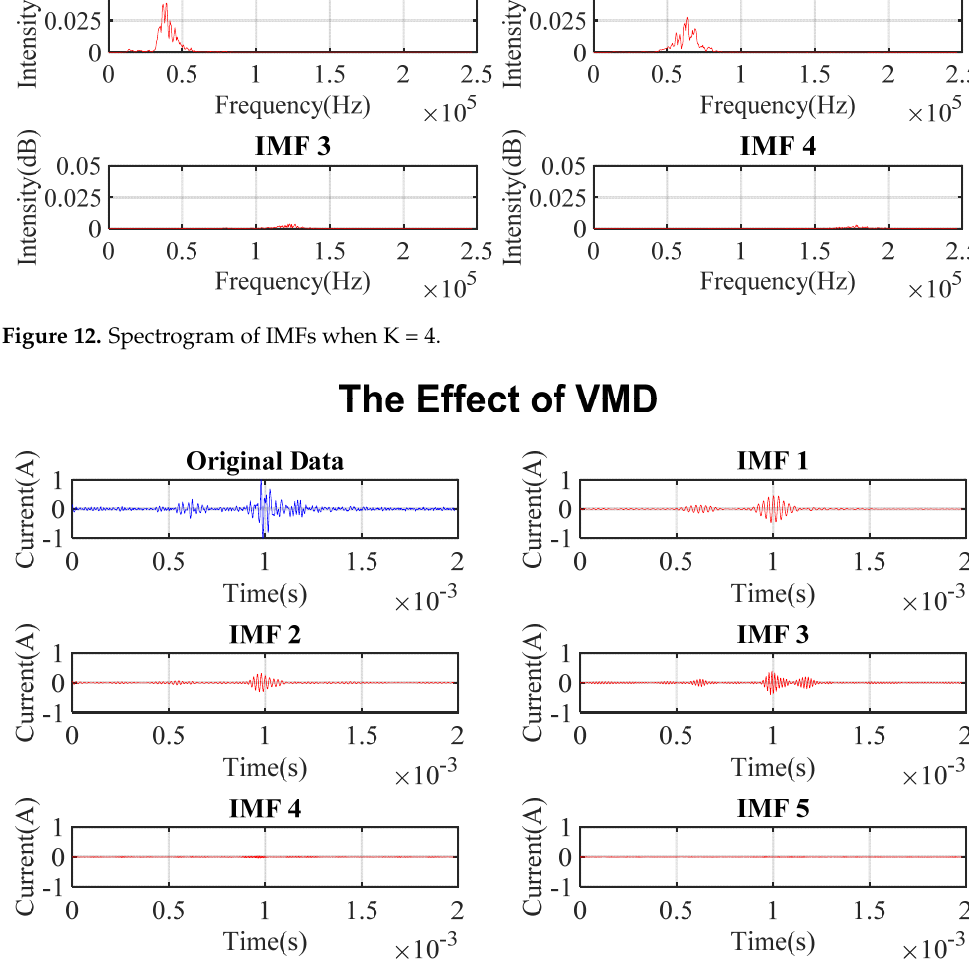
Figure 13. The waveform of IMFs when K = 5.